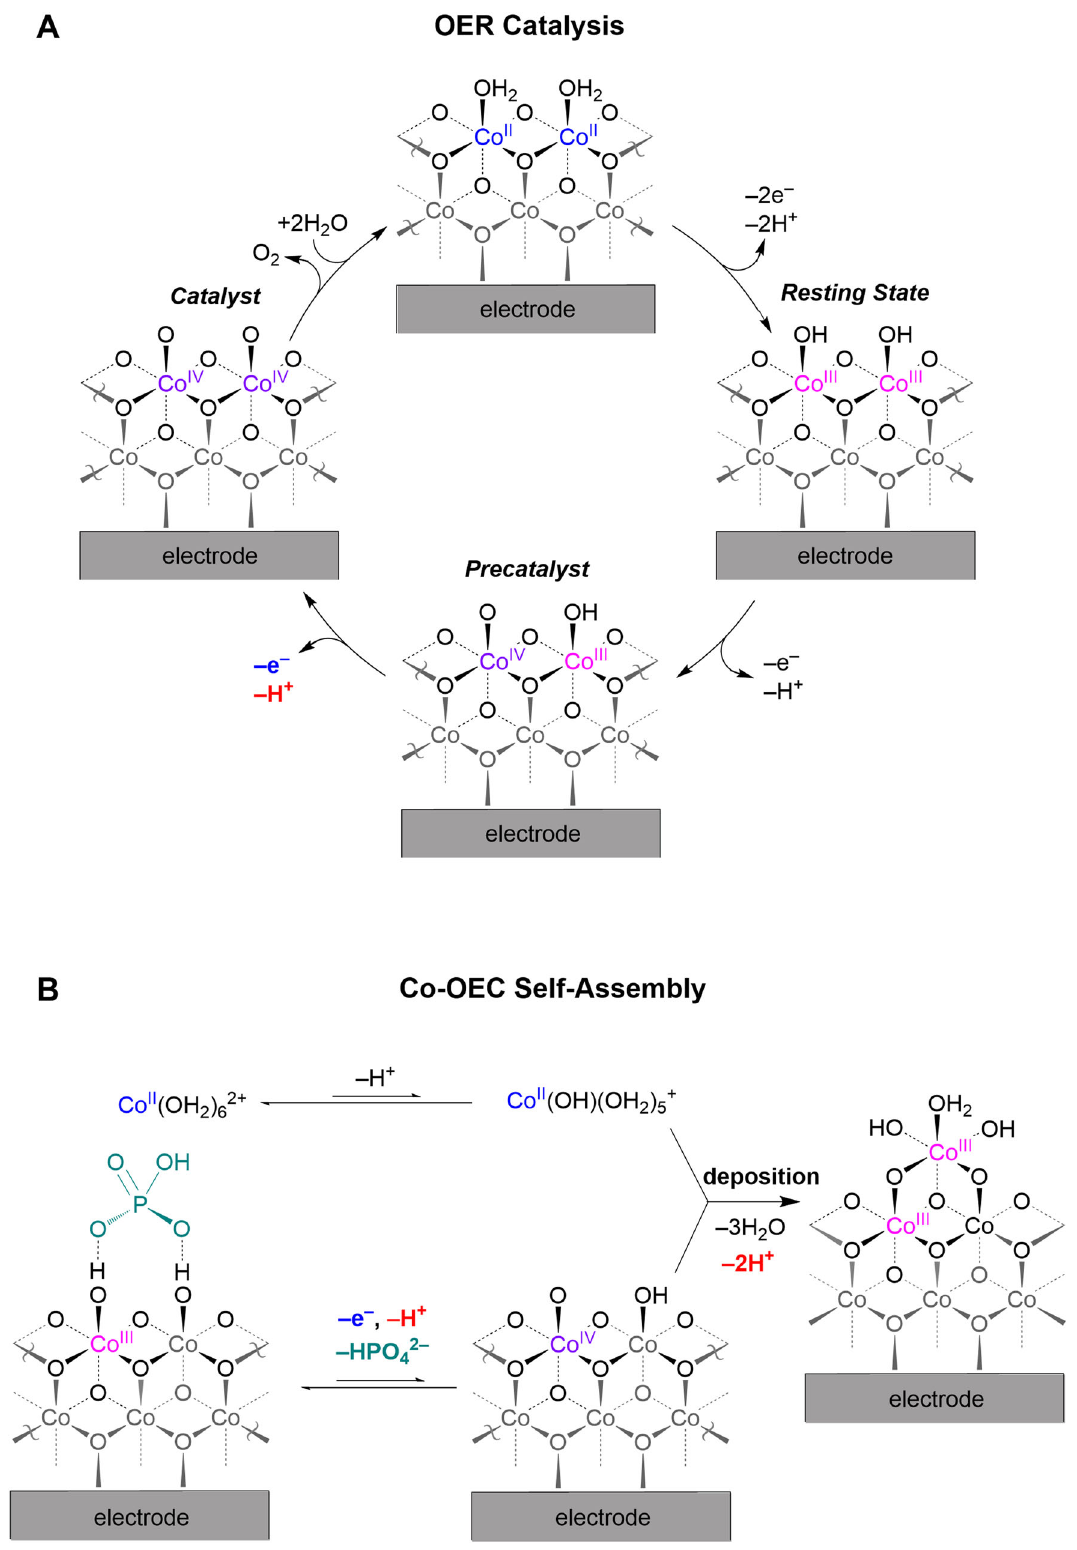
Fig. 2 Co-OEC catalysis and self-assembly. A Proposed OER catalytic cycle (top cycle in Fig. 1A (3)) for Co-OECs (i.e., CoP i , CoMeP i , CoB i ), as determined from spectroscopic analysis and electrochemical kinetics studies for CoP i . B Proposed mechanism for the generation of Co-OEC fi lms (bottom cycle in Fig. 1A (3), and green arrows in Fig. 1B, C). The protons (H + ) that appear in the electrochemical rate laws for OER and catalyst deposition/ regeneration are highlighted in